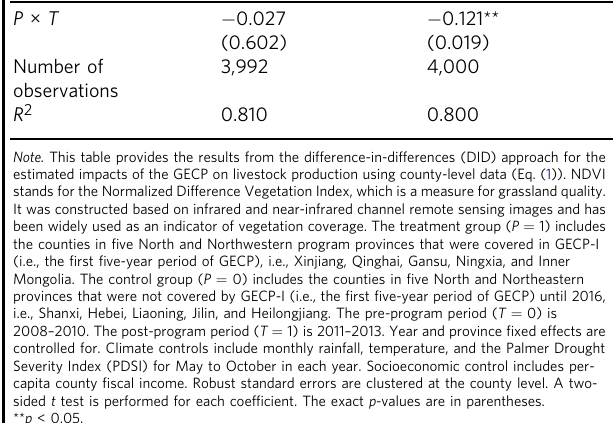
Mongolia. The control group ( P = 0) includes the counties in fi ve North and Northeastern provinces that were not covered by GECP-I (i.e., the fi rst fi ve-year period of GECP) until 2016, i.e., Shanxi, Hebei, Liaoning, Jilin, and Heilongjiang. The pre-program period ( T = 0) is 2008 – 2010. The post-program period ( T = 1) is 2011 – 2013. Year and province fi xed effects are controlled for. Climate controls include monthly rainfall, temperature, and the Palmer Drought Severity Index (PDSI) for May to October in each year. Socioeconomic control includes per- capita county fi scal income. Robust standard errors are clustered at the county level. A two- sided t test is performed for each coef fi cient. The exact p -values are in parentheses. ** p <